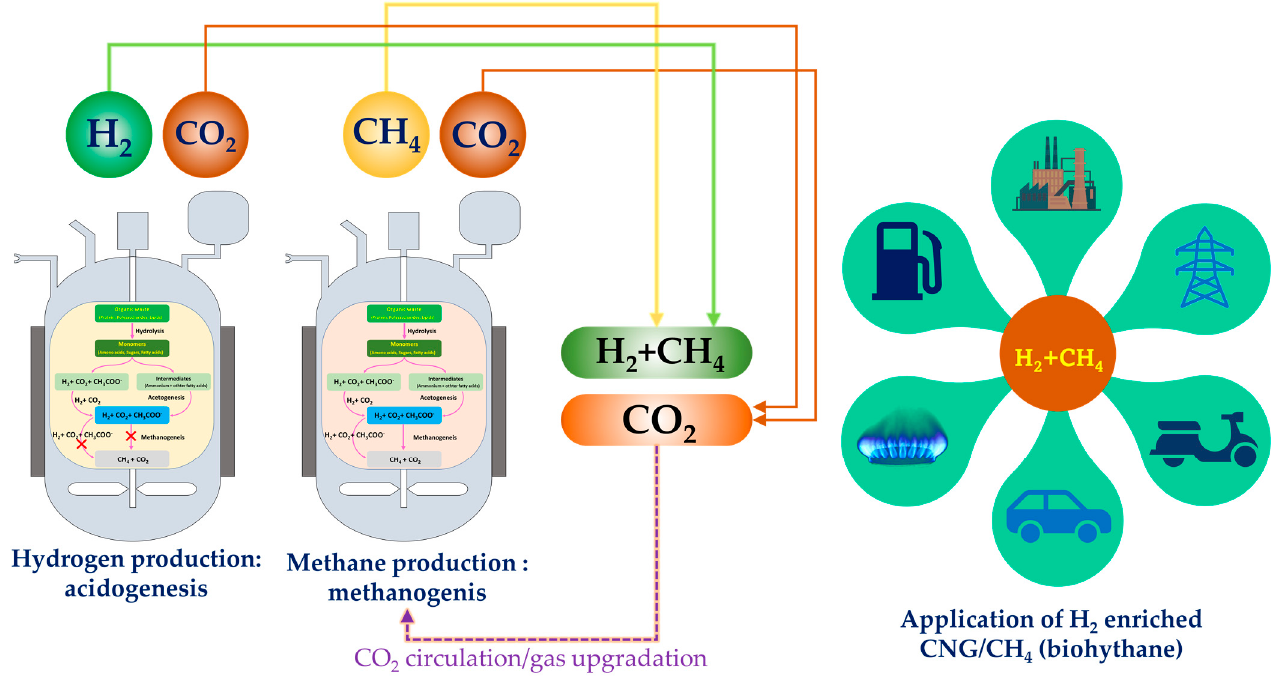
Figure 4. Coupling acidogenesis and methanogenesis to derive bioH 2 and bioCH 4 towards bioH 2 CNG (biohythane) and its application in various sectors. Table 2. Energy of potential biohythane (bio-H-CNG) derived from various feedstock. Process and